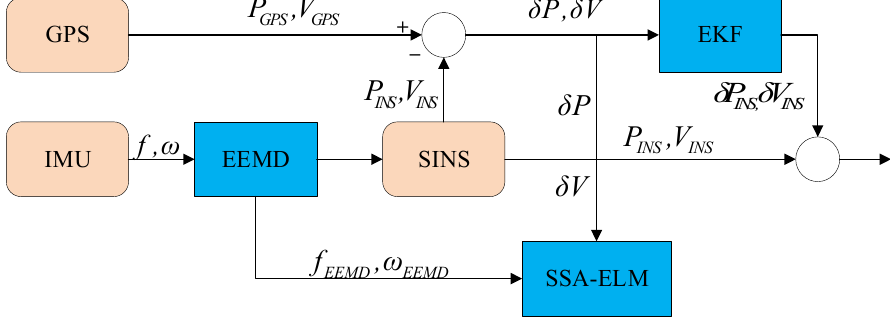
Figure 2. Training mode.